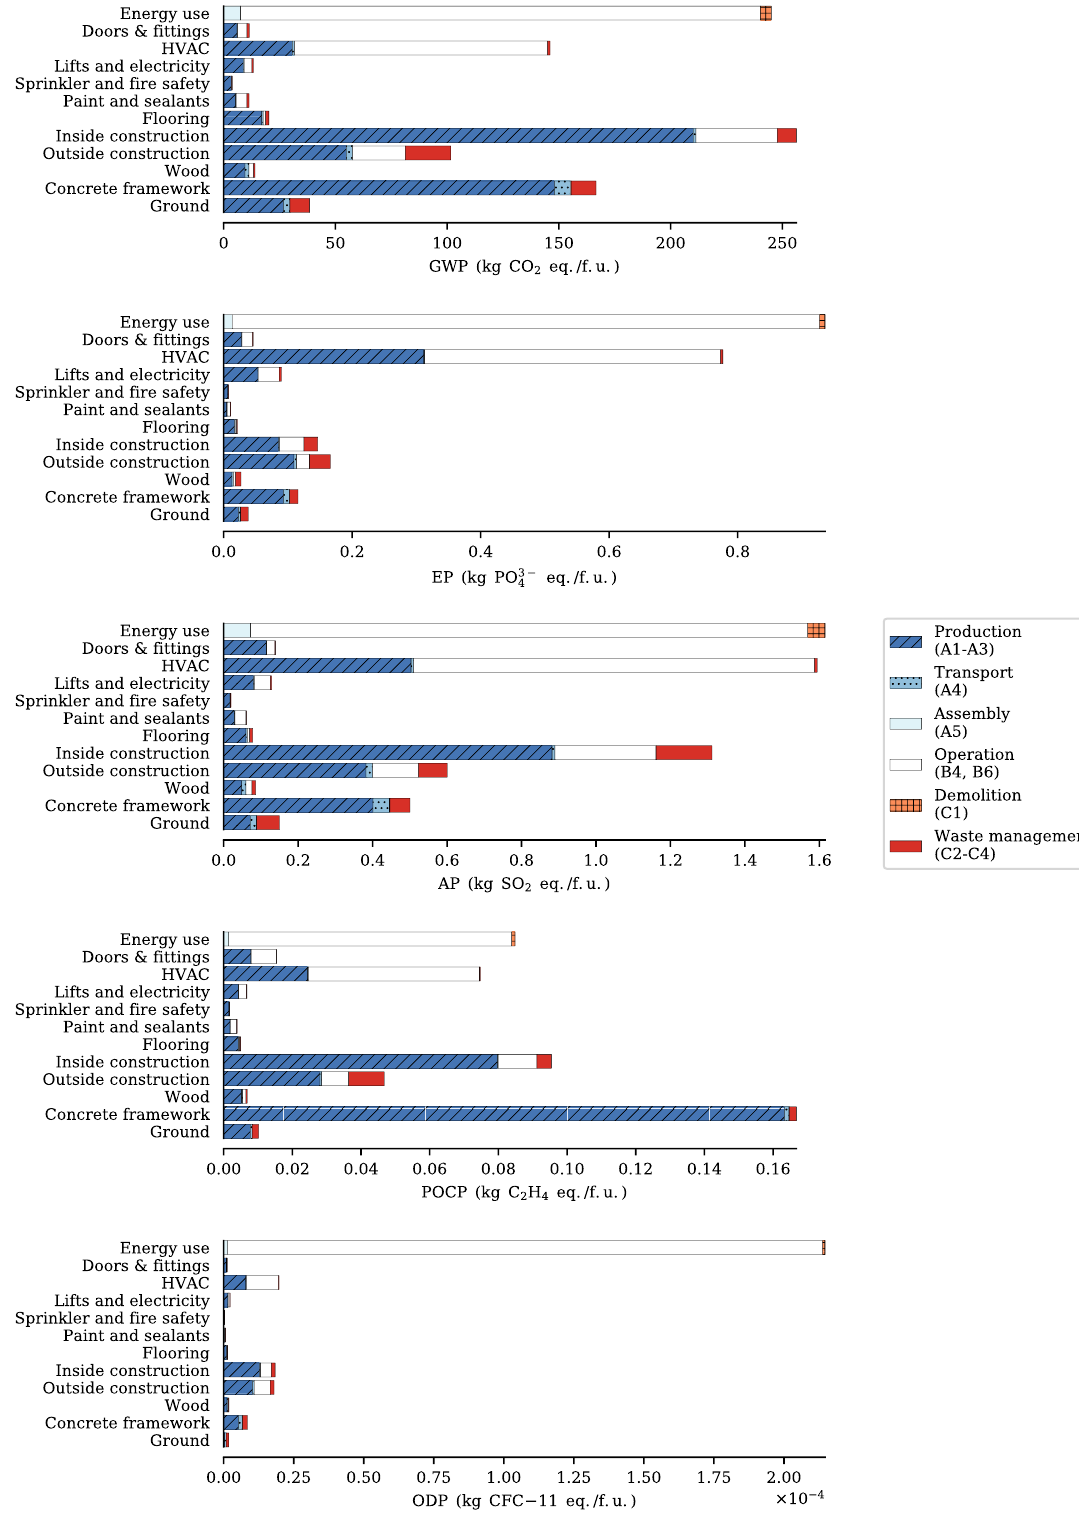
Figure 3. Impact of the different parts in the building for the environmental impact categories